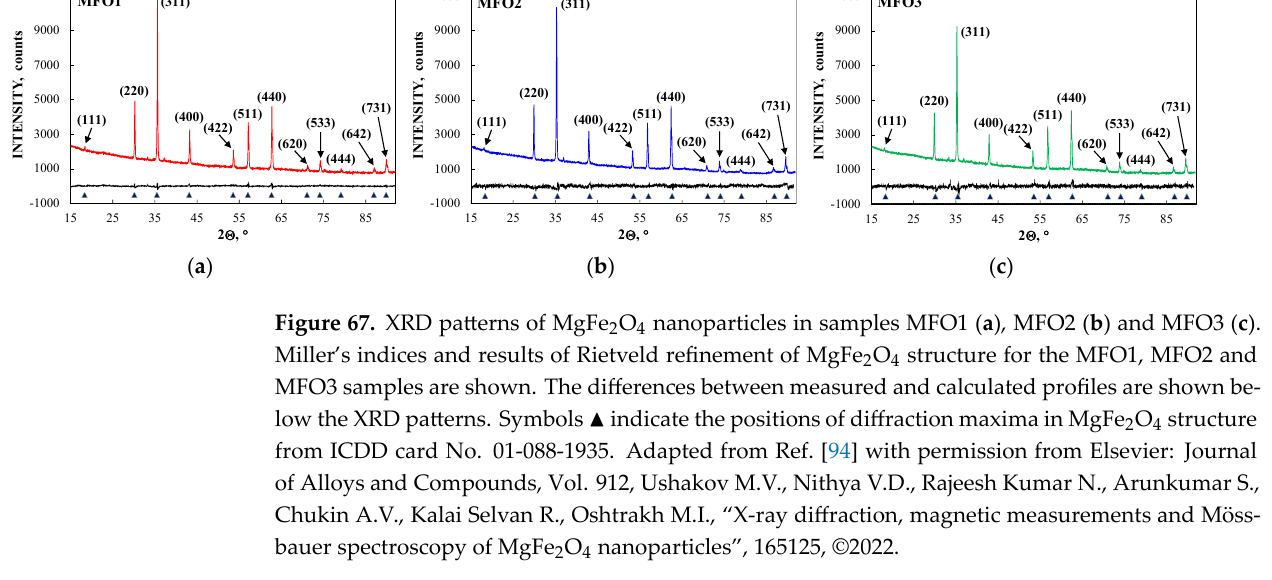
These SEM images show that the MgFe 2 O 4 particles in the samples are agglomerated with a slightly distorted shape. The size of the particles is decreased with increasing the concentration of fuel in the order of MFO1 > MFO2 > MFO3. XRD patterns of MFO1, MFO2 and MFO3 samples are shown in Figure 67. XRD demonstrates the single‑phase spinel composition of these samples as well as the XRD peaks agreed with the same peaks from ICDD card No. 01‑088‑1935 for MgFe 2 O 4 . Crystal structure parameters of the MgFe 2 O 4 samples as well as Fe 3+ and Mg 2+ occupations of the (A) and [B] sites were determined by full profile Rietveld refinement. The inversion parameter was determined as y = 0.9 with a magnesium ferrite formula (Mg 0.1 Fe 0.9 )[Mg 0.45 Fe 0.55 ] 2 O 4 .